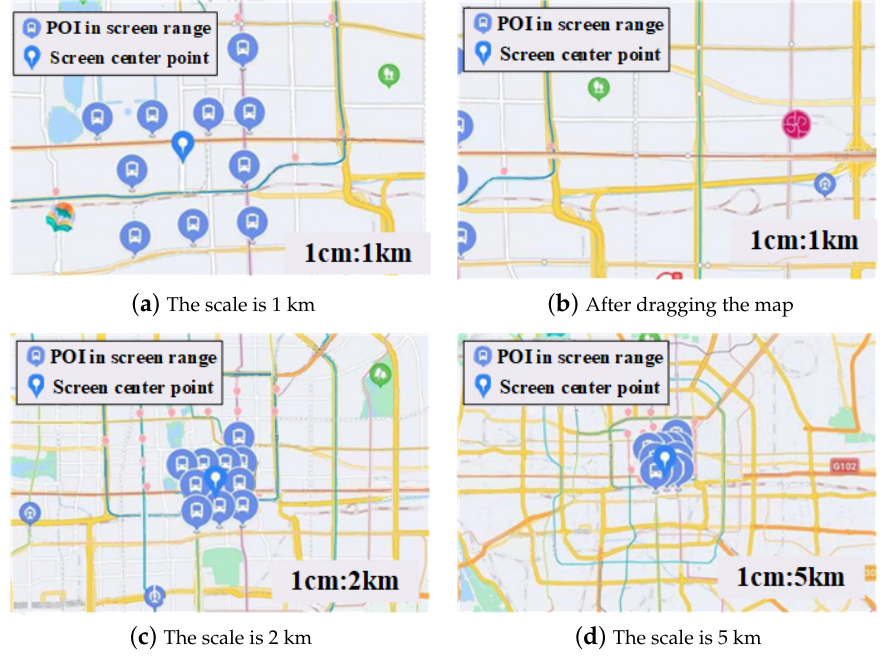
Figure 1. Example of surrounding POIs for existing map